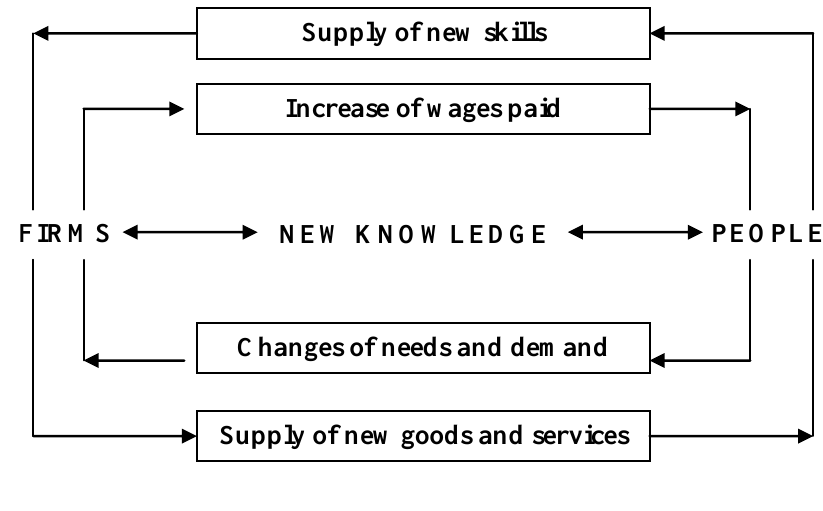
Figure 2 : The Process of Urban Growth and the Creation of New Needs and New